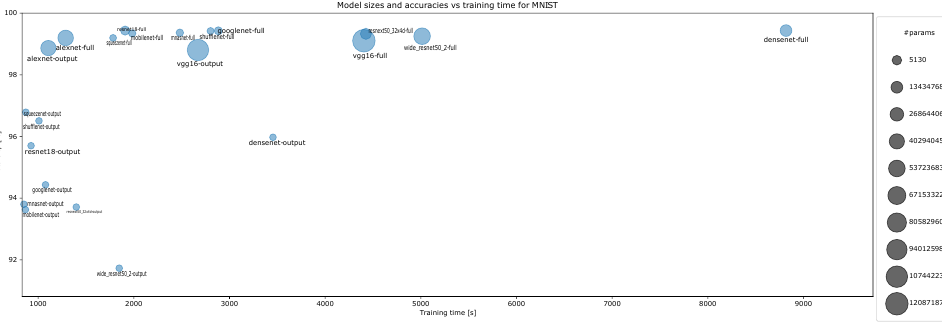
Figure A11. Accuracy vs. training time and model size for CIFAR-10 for ten-episode training.